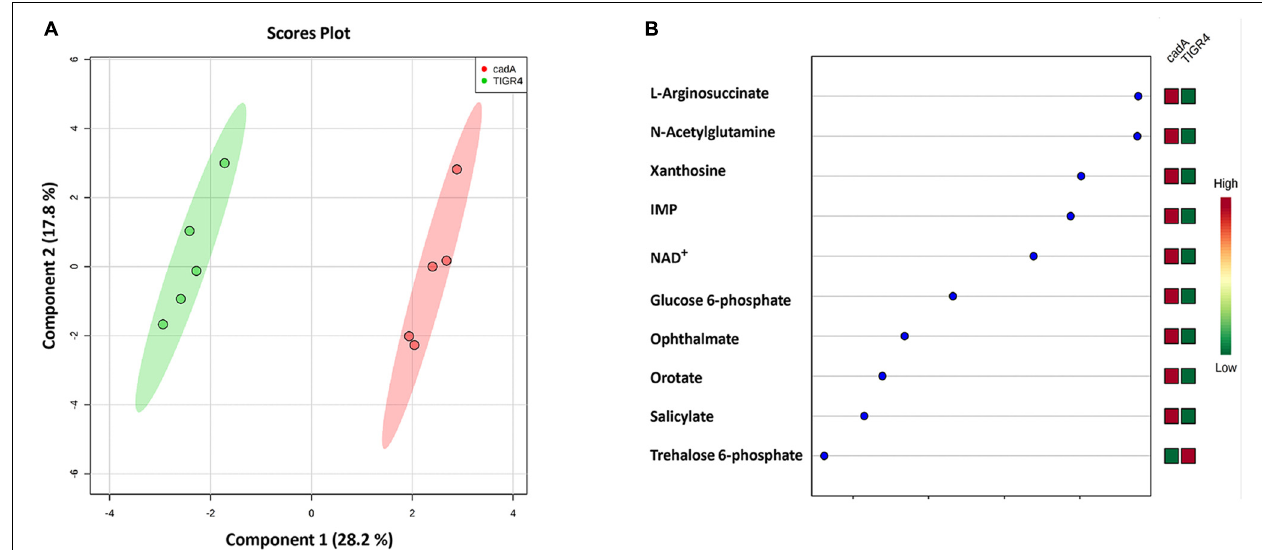
FIGURE 4 | Comparison of the metabolite profiles of S. pneumoniae TIGR4 and (cid:49) cadA . Mass spectrometry-based untargeted metabolomics analysis ( n = 5) was performed with the wild type and polyamine synthesis deficient strain (cid:49) cadA. Peak intensity values of identified metabolites were analyzed by Metaboanalyst 4.0 to identify significant changes in expression. (A) Clustering of samples within the sPLS-DA principal component of the wild type strain TIGR4 (green) and deletion mutant strain (cid:49) cadA (pink) indicate significant metabolic differences between the two strains. (B) sPLS-DA loading plot of TIGR4 and (cid:49) cadA with top ranked metabolites with significant differences in intracellular concentrations between the strains is